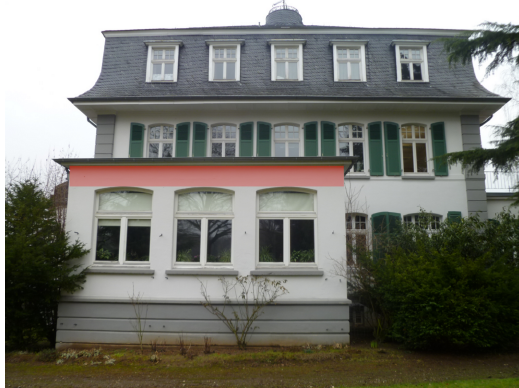
Figure 7: The automatically identified cross section level (in red color) for E STATE